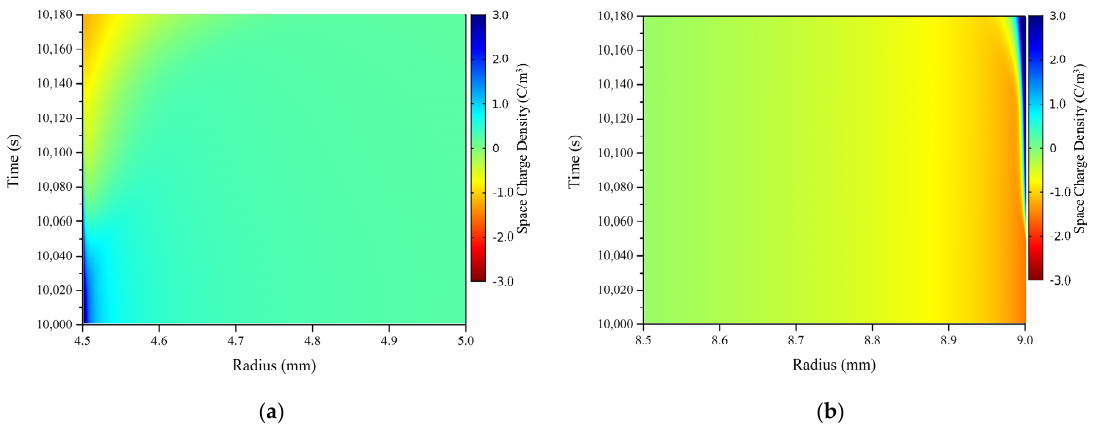
Figure 16. Space charge distribution at 350 A and potential zero duration 60 s: ( a ) Conductor side charge density (C/m 3 ); ( b ) sheath side charge density (C/m 3 ).